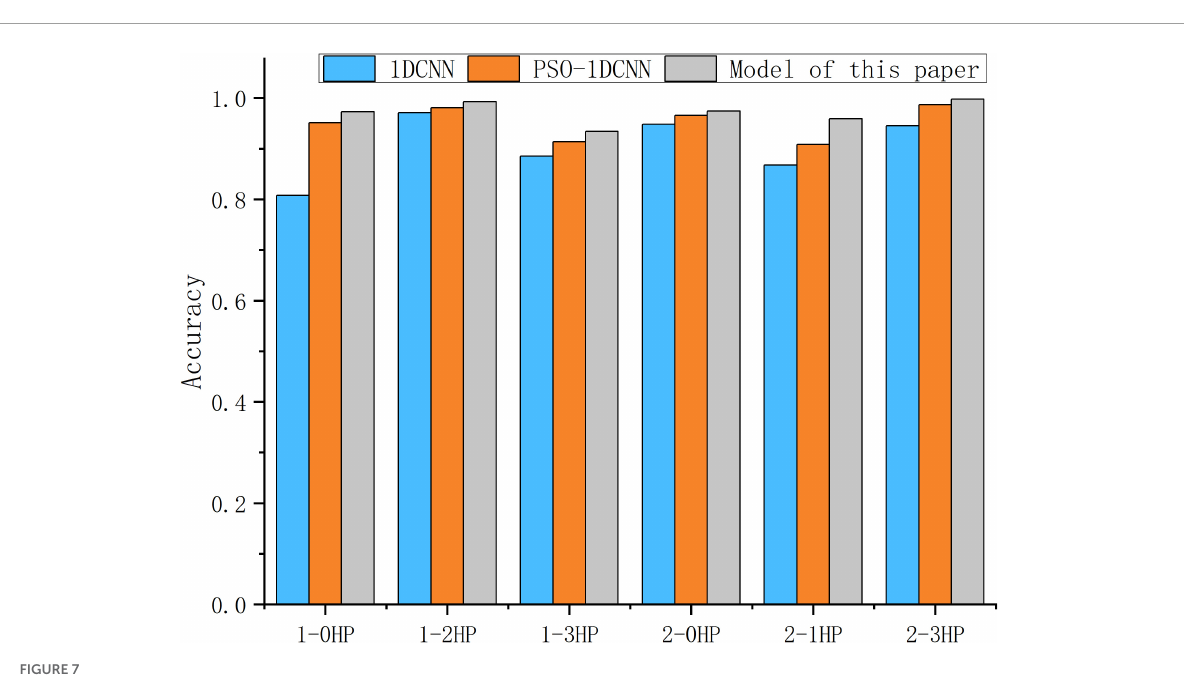
results are shown in Table 3